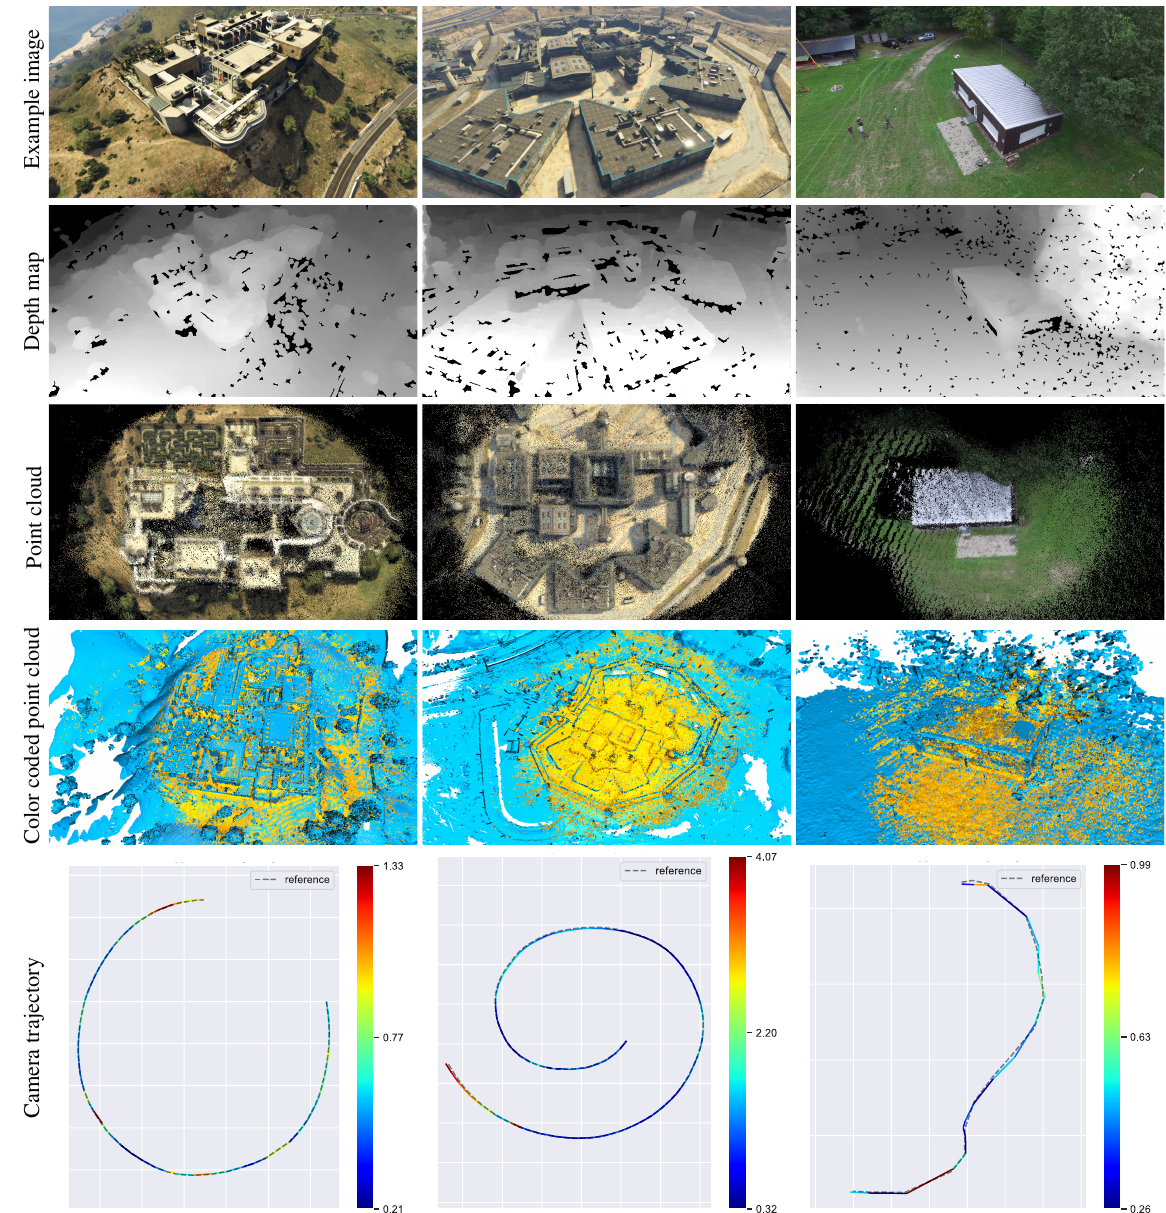
Figure 3. Qualitative results on both datasets. Rows 1 and 2 show exemplary input images with the corresponding estimated depth maps. The following rows display the resulting colored point cloud after flight and the comparison with the ground truth point cloud highlighted blue. The camera trajectory shown in the last row is the projection onto the XY plane. In this, the estimated trajectory is fitted to the ground truth trajectory using least squares due to the missing scale. The resulting error is color coded. point clouds from the position of the camera for each